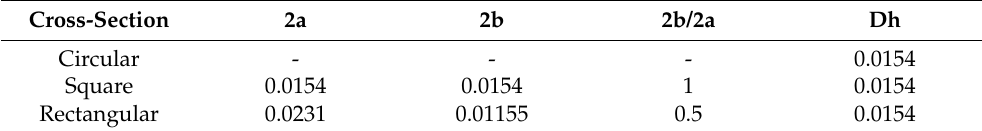
Figure 1. The schematic visualization of the experimental setup. Table 1. The dimensions of different